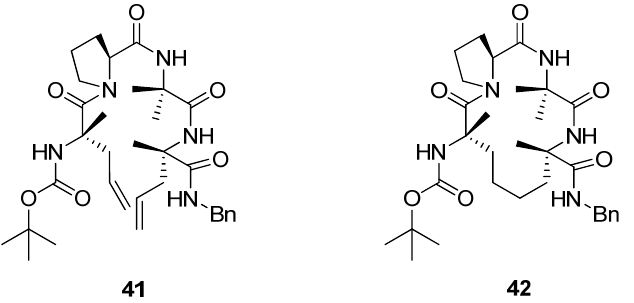
Figure 9. The cyclic peptide 42 and its acyclic precursor 41 both adopt compact type-II β - turn conformations in solution, probably due to the steric requirements of the α , α - disubstituted